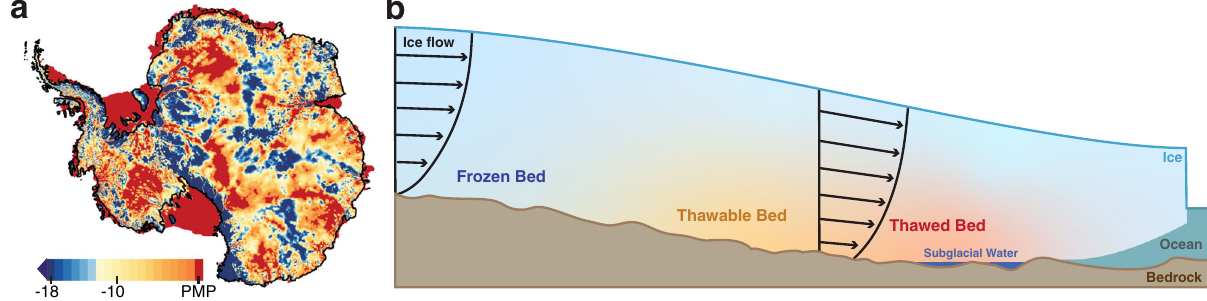
Fig. 1 | Basal thermal state of Antarctica. a Model derived basal temperatures relative to the pressuremelting point(PMP) generated fromourIce-sheet and Sea- level System Model (ISSM) initialization. b Conceptual diagram of the transition